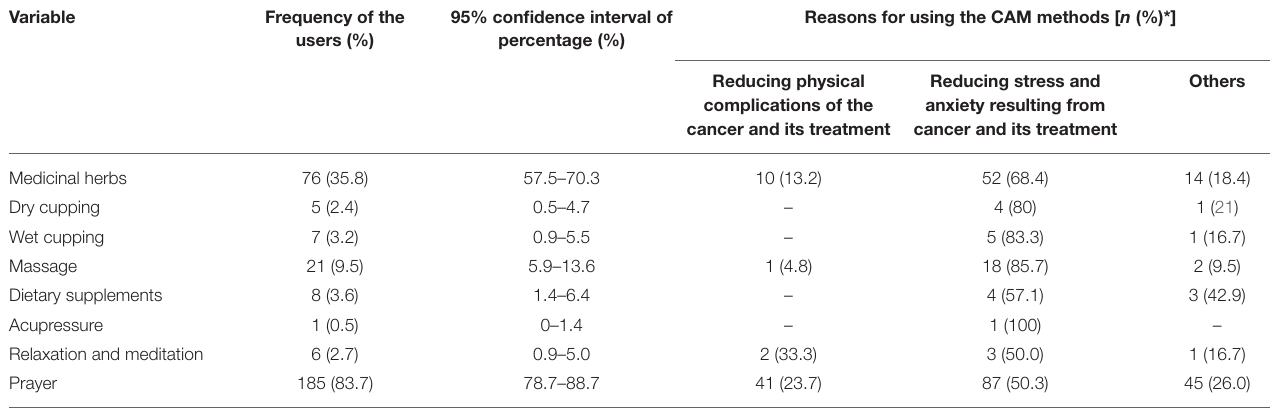
TABLE 3 | The use of CAMs and the reasons for using each type of CAMs in terminally ill cancer patients. Variable